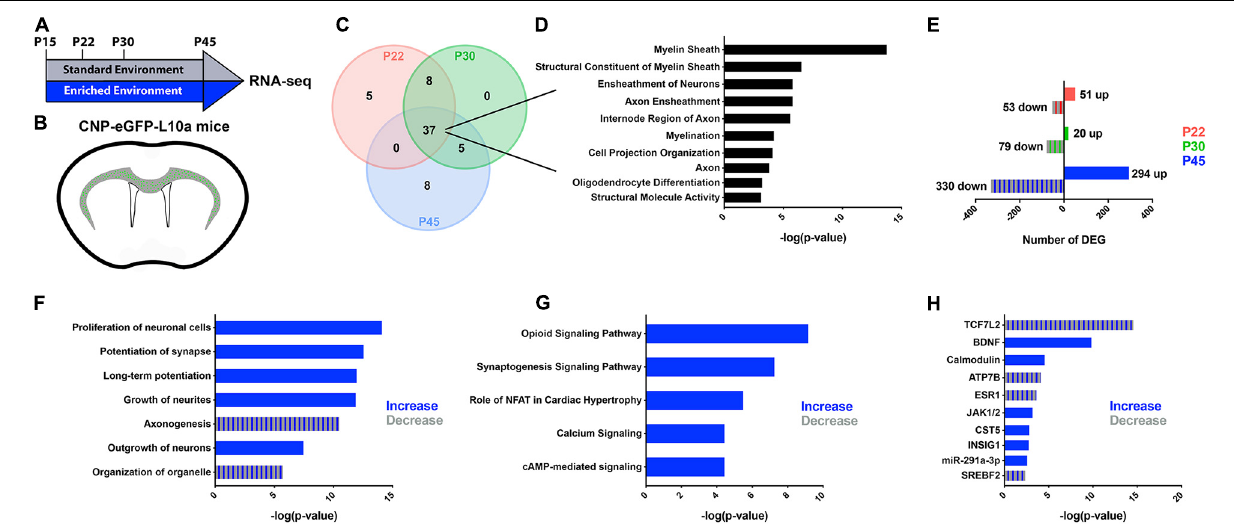
FIGURE 1 | RNA-seq reveals changes in the OL translatome following prolonged EE. (A,B) Schematic representation of the experimental timeline (A) and GFP-expressing oligodendrocytes in the subcortical WM of CNP-bacTRAP mice (B) . (C) Venn Diagram of the 50 highest-expressed RNAs in subcortical WM OLs at P22 (red), P30 (green), and P45 (blue). (D) Gene ontological analysis of 37 OL RNAs highly expressed at all timepoints. This list was generated using g:profiler, and is comprised of the top ten molecular functions, biological processes, or cellular components ranked by − log( p -value). (E) Number of differentially expressed genes between EE and SD mice at P22, P30, and P45 (Wald test with Benjamini-Hochberg post hoc , adjusted p < 0.05, normalized counts > 5) (P22: SD, n = 4, EE, n = 6; P30: SD, n = 5, EE, n = 4; P45: SD, n = 4, EE, n = 6). (F–H) Predicted increases (blue) and decreases (blue/gray stripes) in cell and molecular functions (F) , pathways (G) , and upstream regulators (H) , in EE compared to SD OLs at P45 (determined by directional z-scores). Cell and molecular functions, pathways, and upstream regulators are ranked based on p- value as determined using Fisher’s Exact